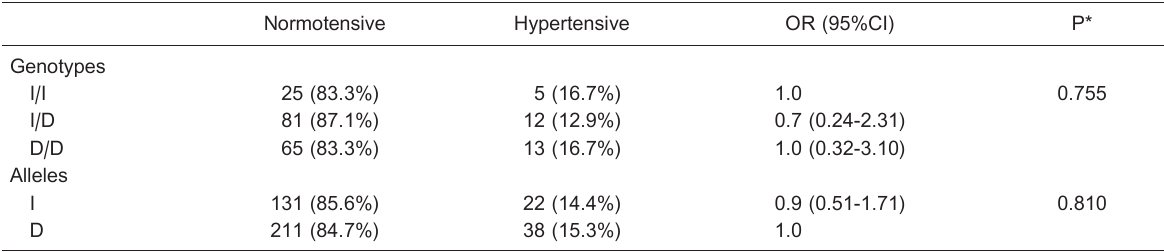
Table 1. Analysis of the association between the I/D polymorphism of the ACE gene and